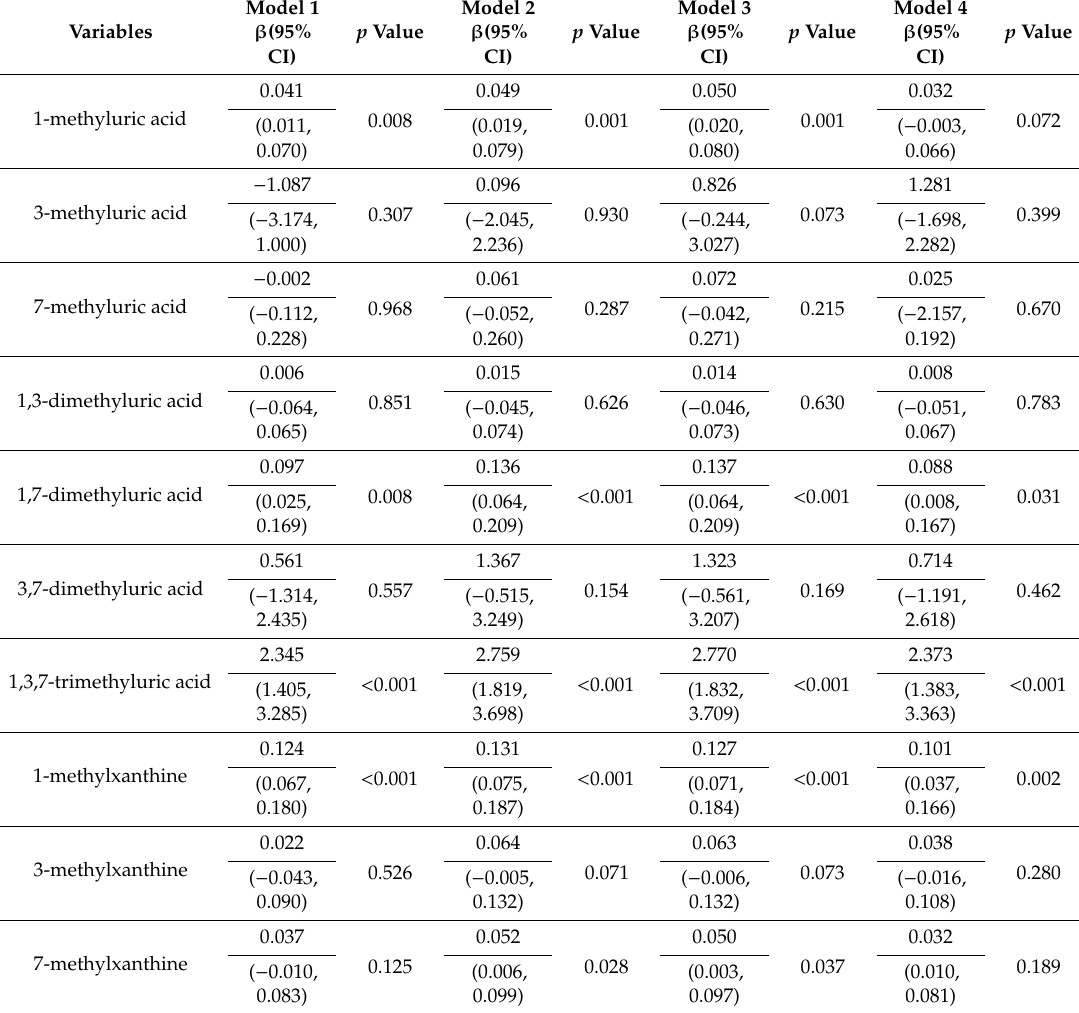
Table A1. Association between urinary ca ff eine metabolites and urine flow rate in NHANES